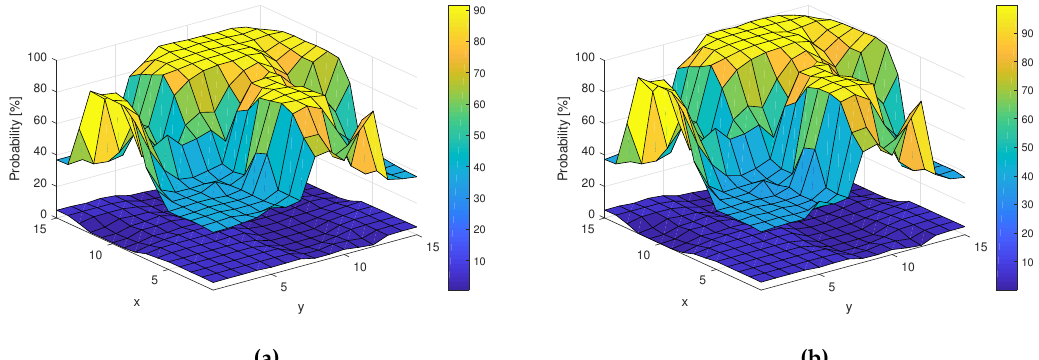
Figure 17. Probabilities P d and P fa in different locations for the applied Random Forest method. ( a ) P d and P fa surfaces for Energy Detection-based Random Forest; ( b ) P d and P fa surfaces for Energy Vector-based Random Forest.